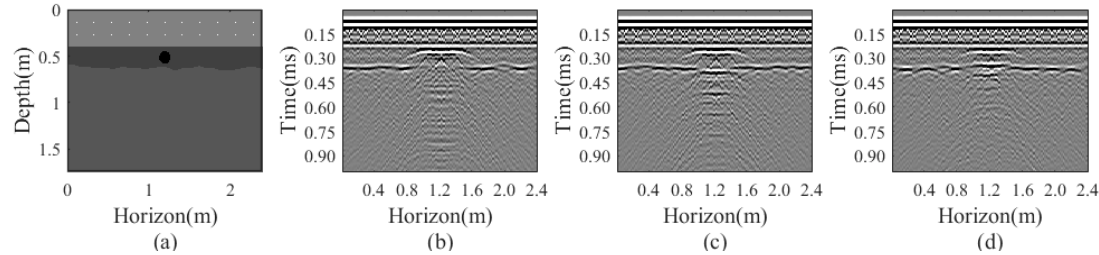
Figure 9. Synthetic seismic detection of ( a ) grouting defects filled with ( b ) air, ( c ) water, and ( d ) clay.